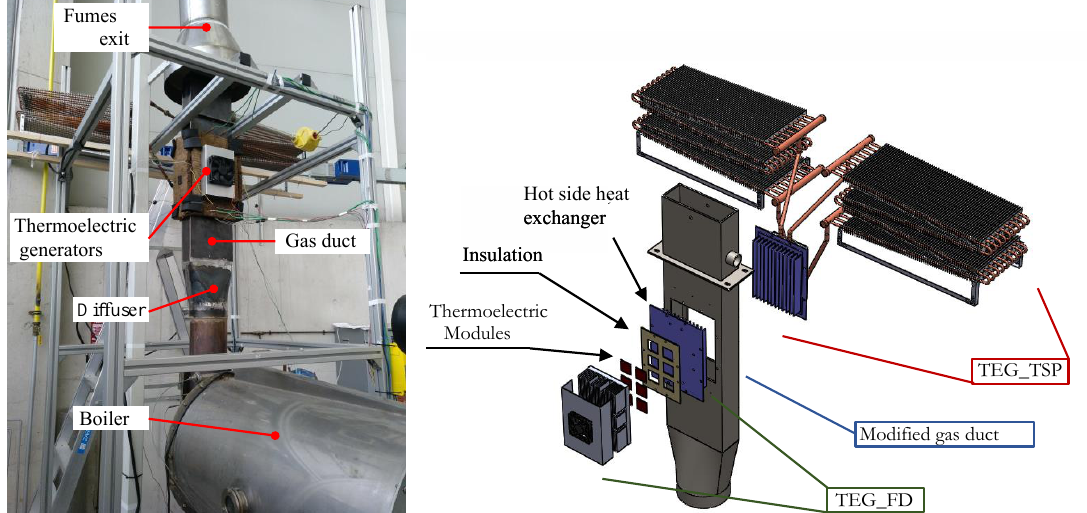
Figure 10. Thermoelectric generators built and installed at the exhaust pipe of the boiler. Scheme of the parts that form the prototypes and their